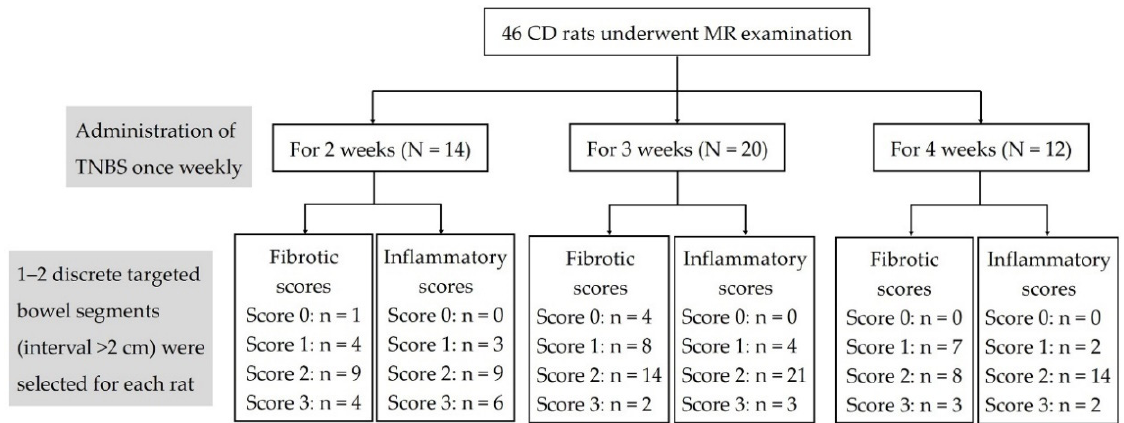
Figure 1. Flowchart of the animal model results and histologic evaluations. CD = Crohn’s disease; MR = magnetic resonance; N = the number of rats; n = the number of bowel specimens; TNBS = 2,4,6-trinitrobenzene sulfonic acid.